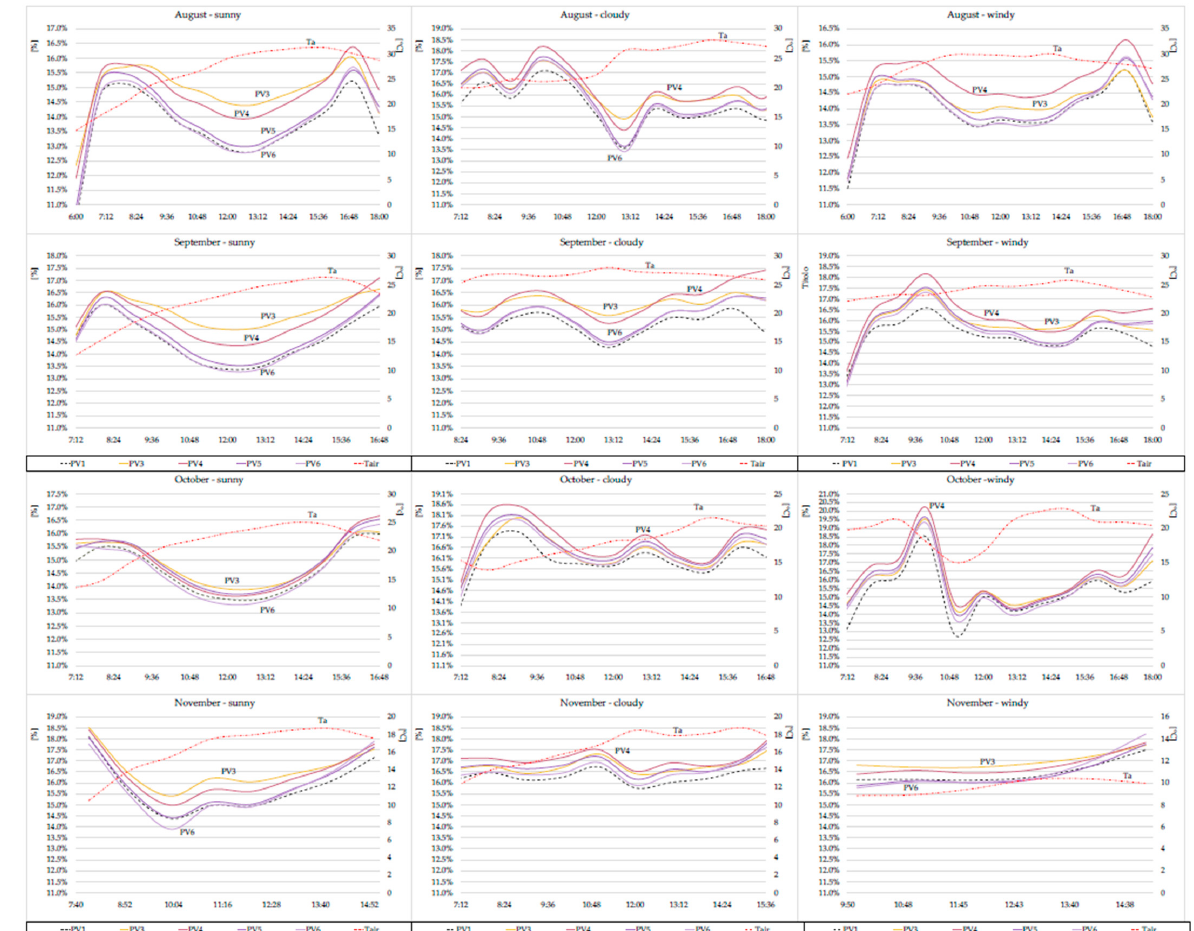
Figure 6. Output power and electric efficiency of the reference module and the four modules equipped with cooling systems in three different climatic conditions for the months of December 2016, January, February and March 2017.